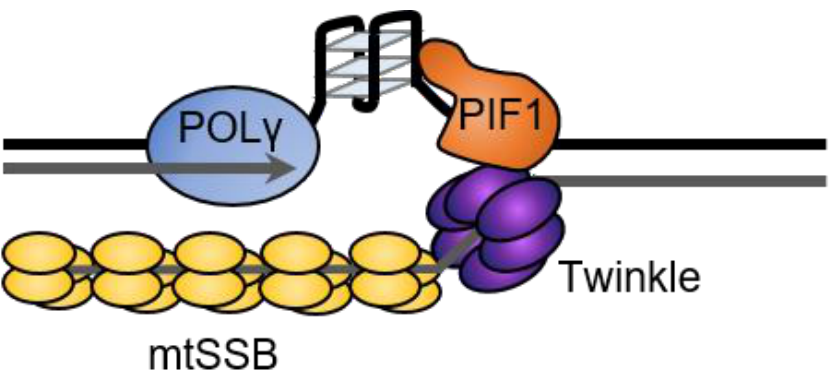
Figure 7. Pif1 promotes synthesis through G4 sequences by yeast and human mitochondrial poly- merases. The role of Pif1 may be to unfold G4 structures that fold after the unwinding of the duplex before synthesis occurs.